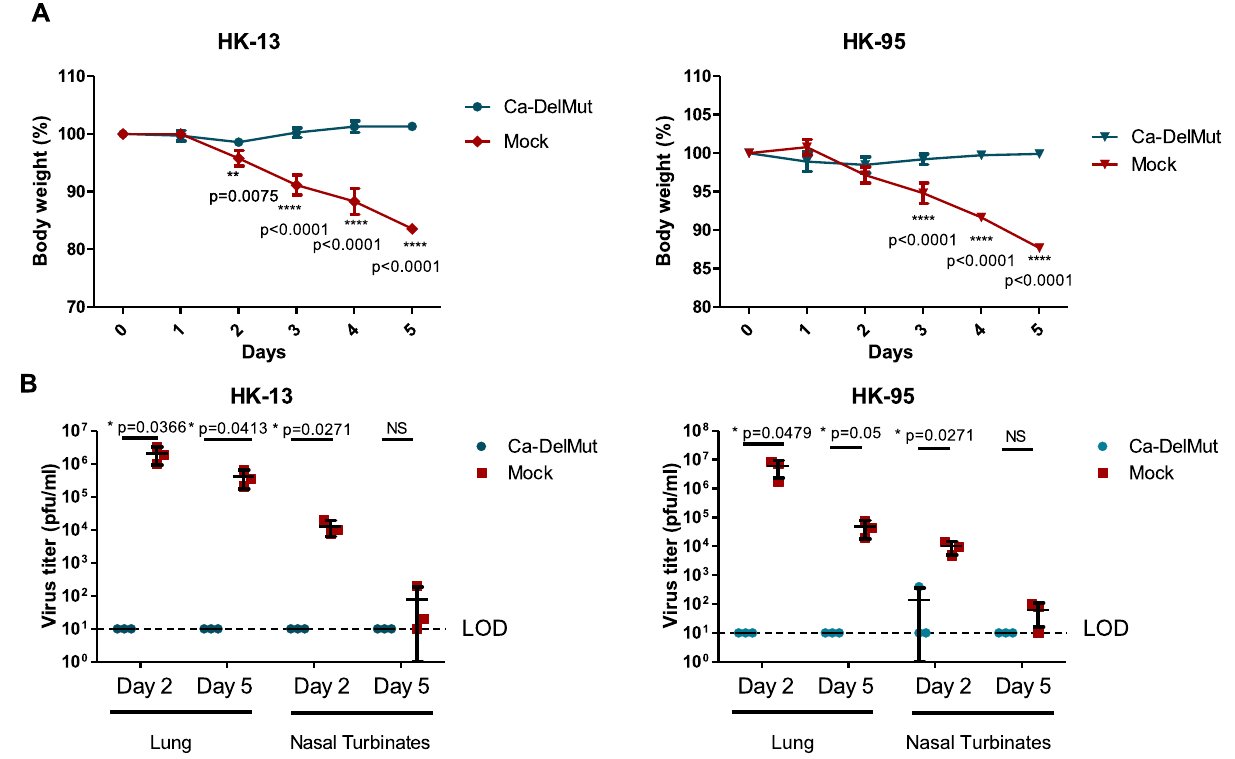
Fig. 6 Ca-DelMut immunization protection against WT virus challenge in hamsters. Hamsters were inoculated with 1.25 × 10 5 pfu Ca-DelMut ( n = 12) or mock immunized ( n = 12). At day 28 after immunization, hamsters were challenged with 1 × 10 3 pfu of either HK-13 ( n = 6) or HK-95 ( n = 6) virus. A Body weight and disease symptoms were monitored for 5 days. Error bars represent mean ± SD ( n = 3). Statistical comparisons between means were performed by two-way ANOVA with Bonferroni post-test: **** p < 0.0001, *** p < 0.001, ** p < 0.01. B At days 2 and 5 post-infection, lungs and nasal turbinate tissues were collected for virus titration and histopathological study. Error bars represent mean ± SD ( n = 3). Statistical comparisons between means were performed by Student ’ s t -test (2-tailed): * p < 0.05, NS: not signi fi